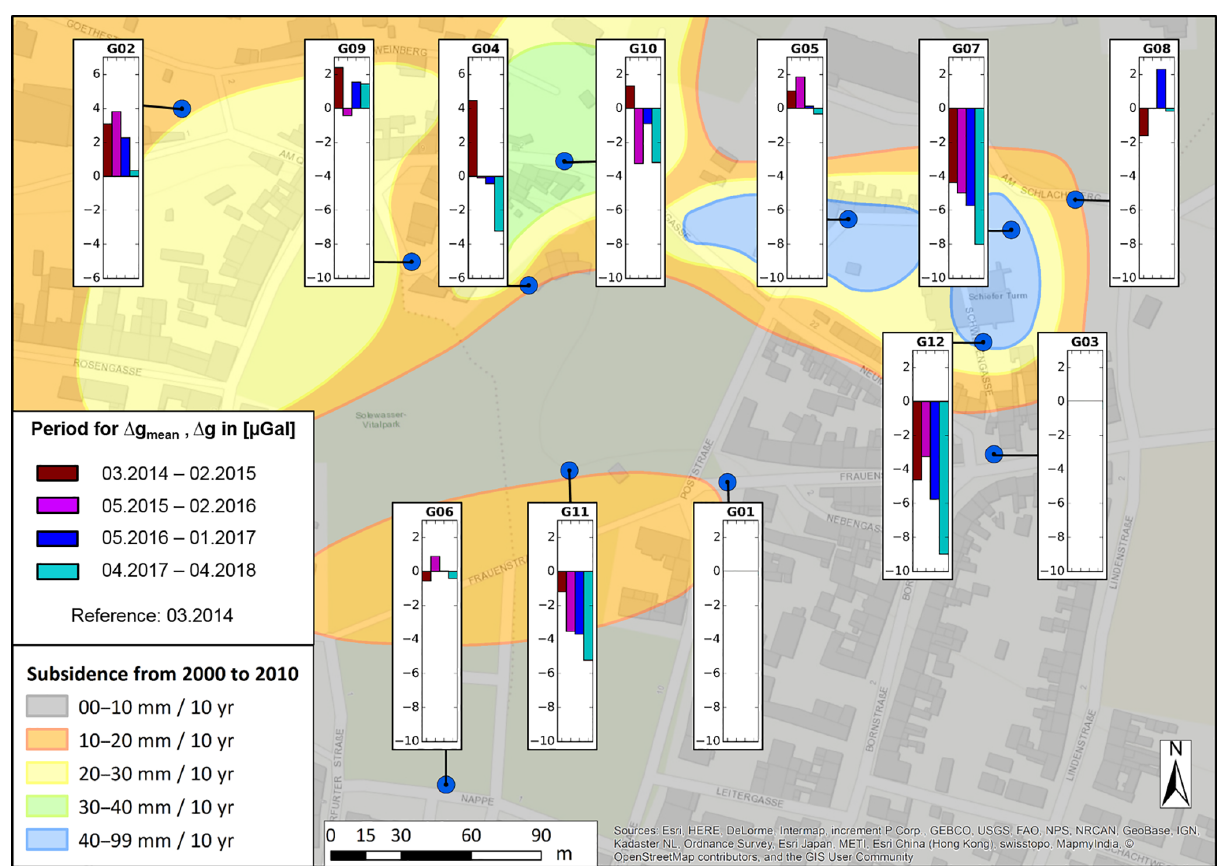
Figure 10. Temporal variations of mean gravity (cid:49)g mean over each year of data, referenced to March 2014, on the points of the gravimetric network (blue dots). The gravity values for each survey point are derived from least squares adjustments assuming that G01 and G03 are stable over time. The adjusted gravity differences are hydrologically corrected for soil water content by applying an individual regression coefficient for each gravity